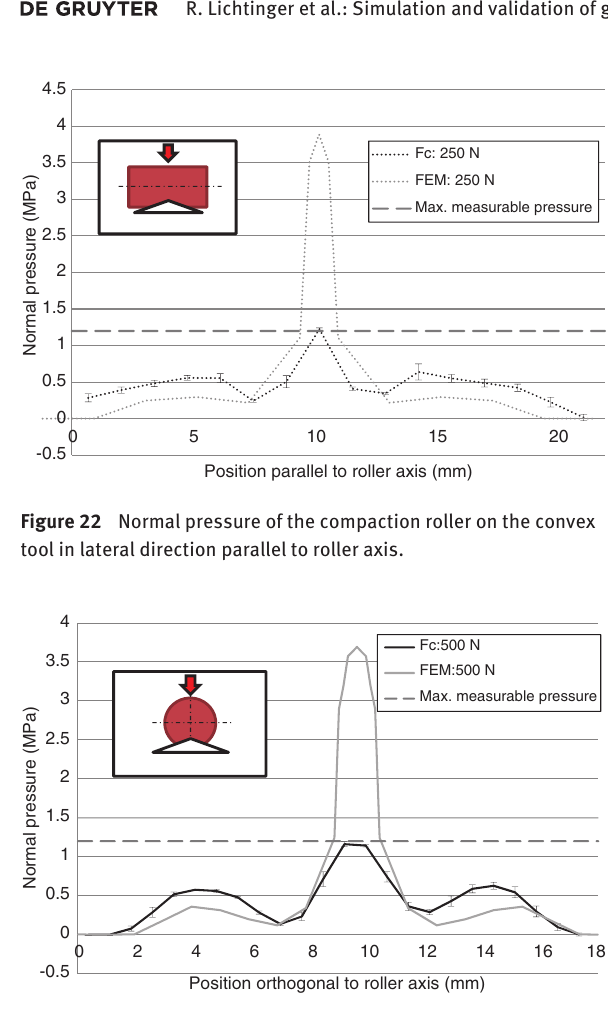
Figure 23 Normal pressure of the compaction roller in longitudinal direction orthogonal to roller axis on the convex tool.